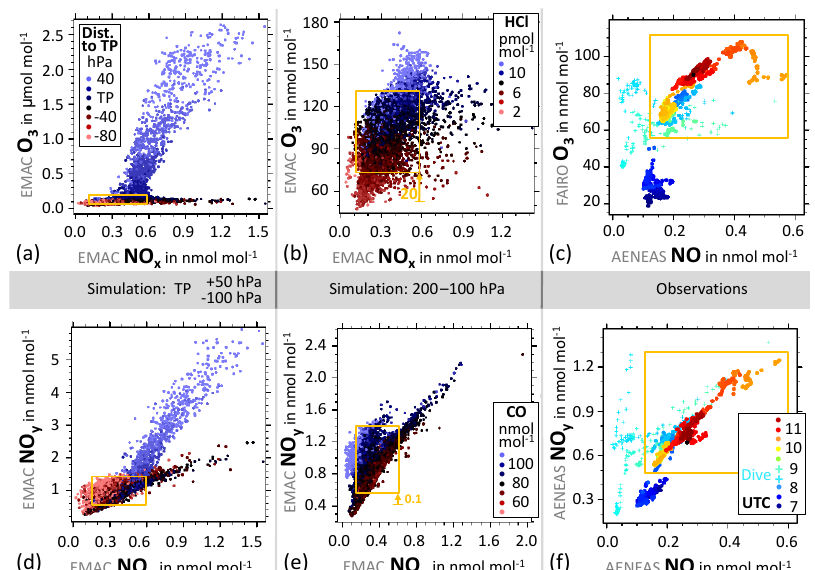
Figure 9. As in Fig. 8, but focusing on reactive nitrogen. Panels (c) and (f) show NO instead of NO x , because only NO was measured. In the daytime, i.e. at the time of the measurements, NO is good proxy for NO x . The legend from panel (a) also applies to (d) , and the legend from (f) applies to (c)